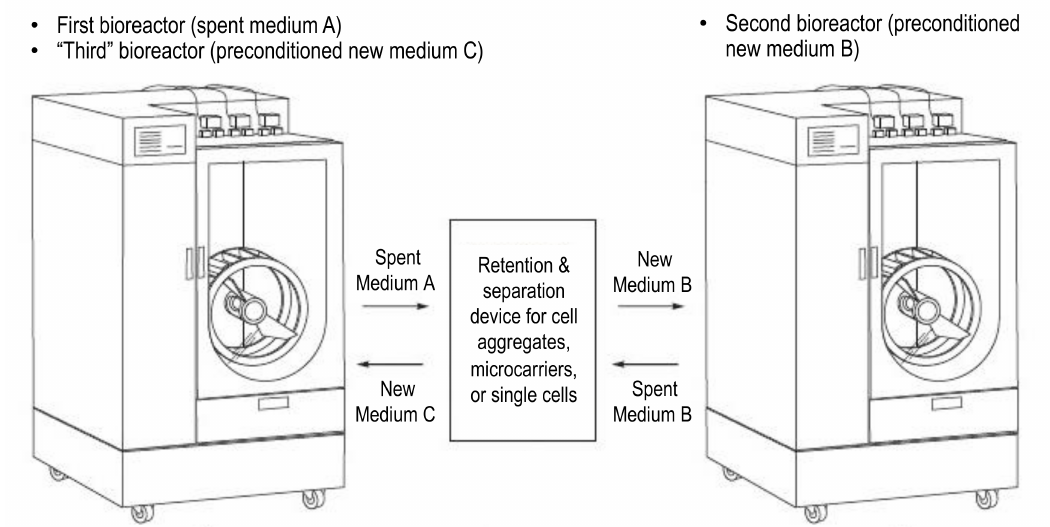
Figure 6. A methodology for using an external retention and separation device in conjunction with multiple bioreactors to facilitate rapid, complete, and scalable medium